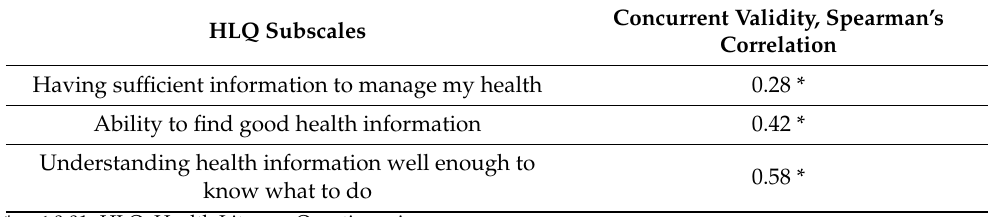
Table 5. Concurrent validity of the three health literacy screening questions ( n =